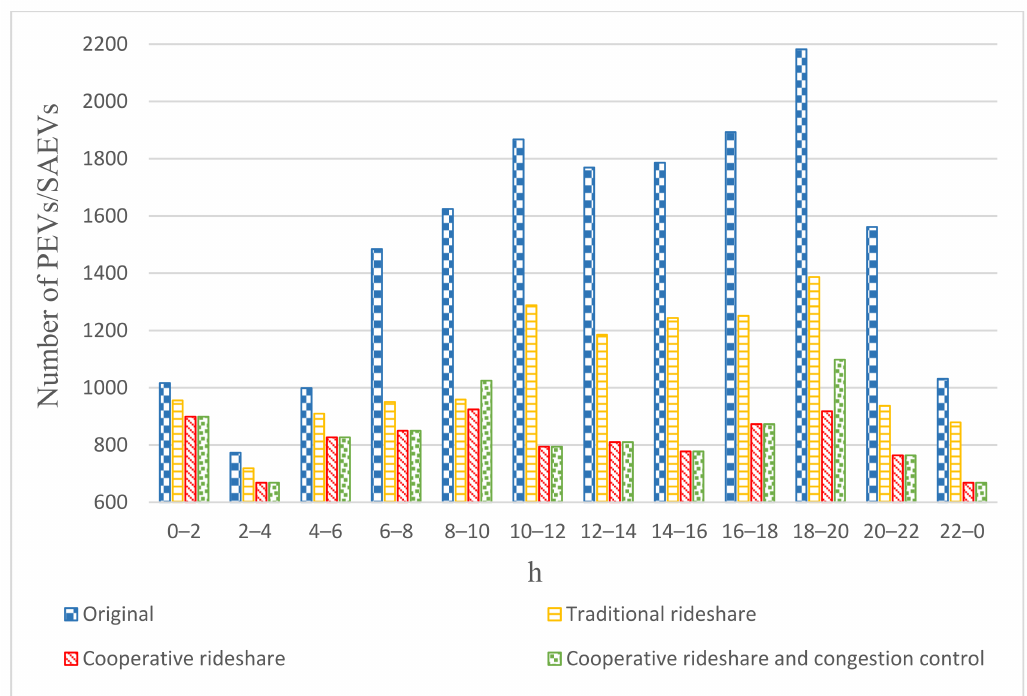
Figure 13. Traffic volumes of PEV/SAEV passengers on the municipal